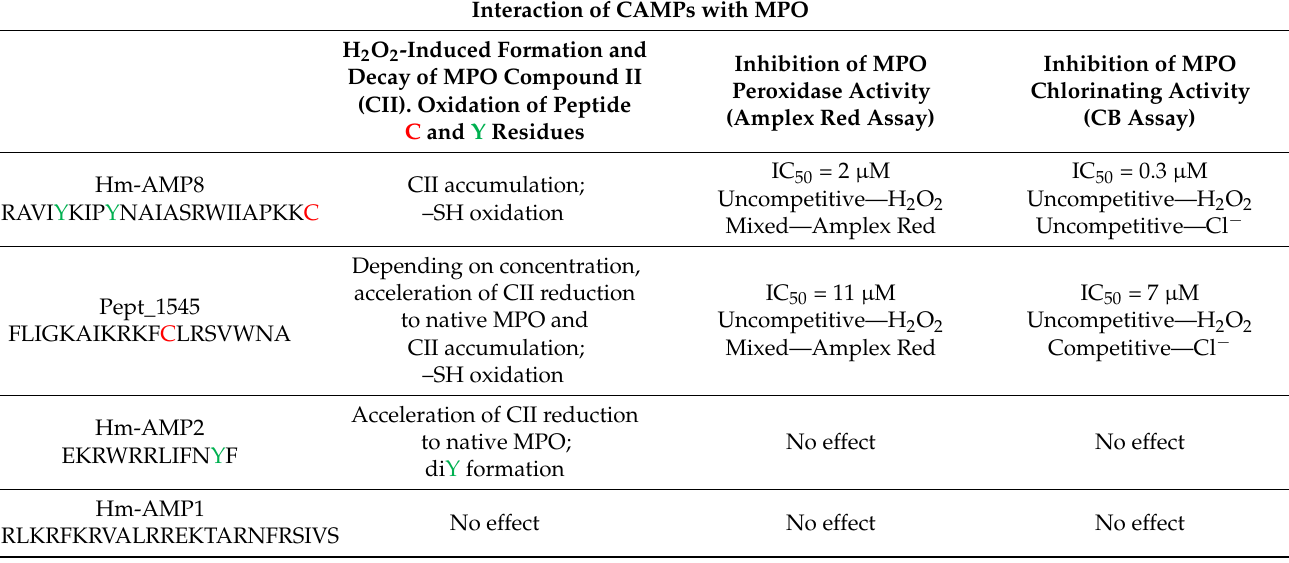
Table 5. Summary of findings